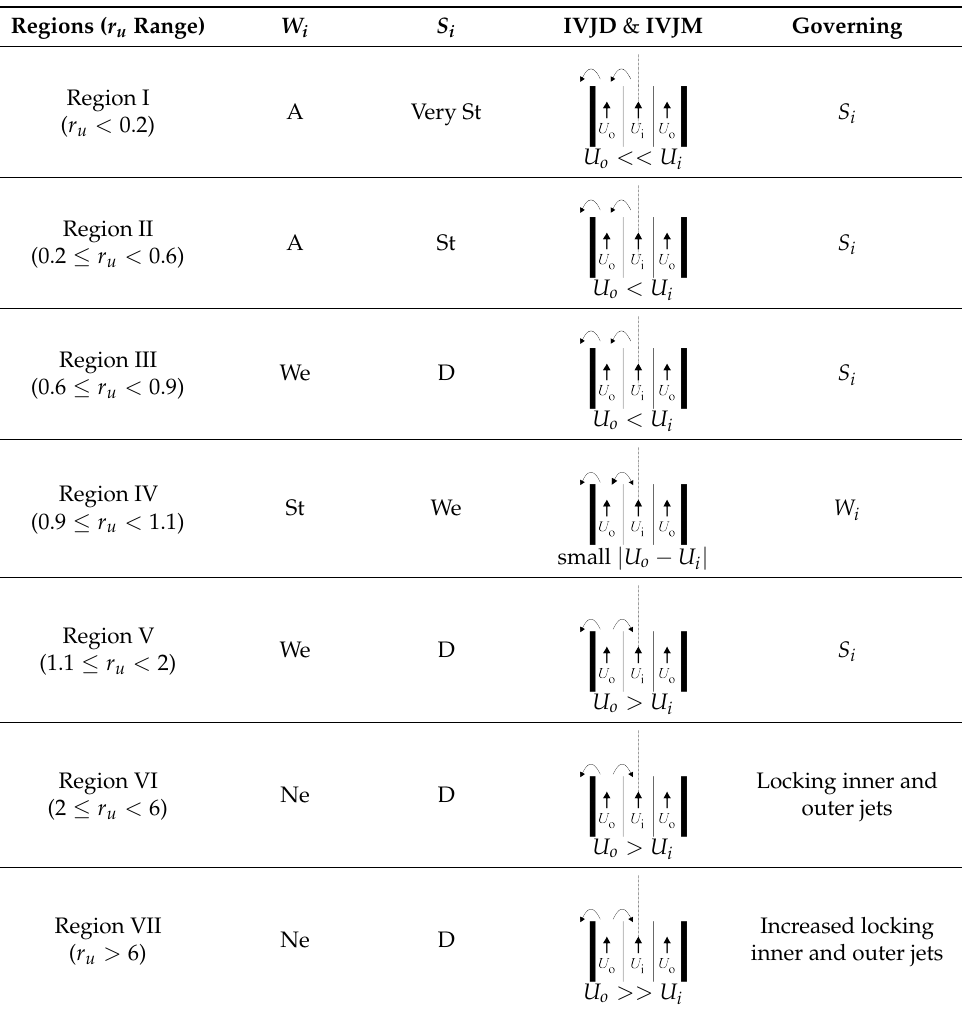
Locking inner and outer